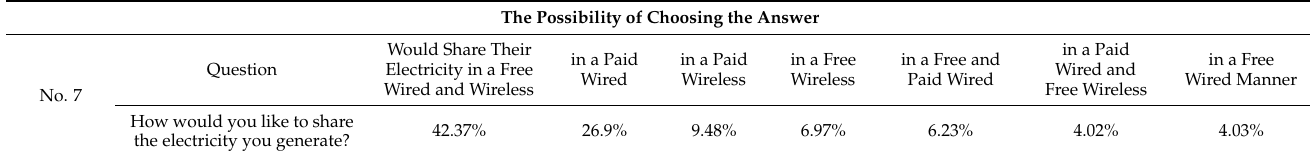
Table 7. Question no. 7, research